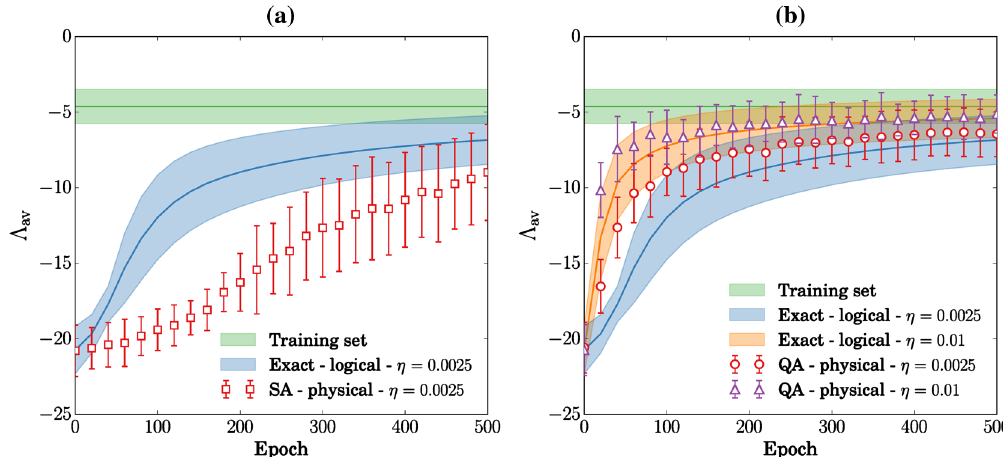
FIG. 7. Comparison of different learning settings. The plots show mean and 1 standard deviation of the proxy Λ instances and for different learning procedures. We use exact gradient for the 15-variable logical graph and quantum annealing (QA) or simulated thermal annealing (SA) for the corresponding 76-qubit physical graph. A learning procedure is considered successful if it can generalize, that is, if it matches the proxy of the training set (green band). (a) The logical model (blue band) matches faster than the physical model (red squares) when the same learning rate is used. This suggests that the larger number of parameters does not help the physical model. (b) Quantum annealing on the physical graph (red circles) enables faster matching than exact gradient on the logical graph (blue band) when the same learning rate η ¼ 0 . 0025 is used. However, the exact-gradient procedure equipped with a larger learning rate η ¼ 0 . 01 (orange band) outperforms the quantum-assisted algorithm. In turn, the quantum-assisted algorithm outperforms all other learning procedures when equipped with the larger learning rate η ¼ 0 . 01 (purple triangles). Notice that neither the computation of Λ nor the exact-gradient learning is tractable, in av